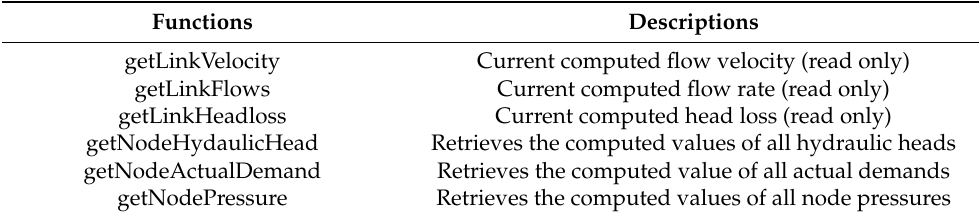
Table 1. List of some Matlab Class Functions. Functions